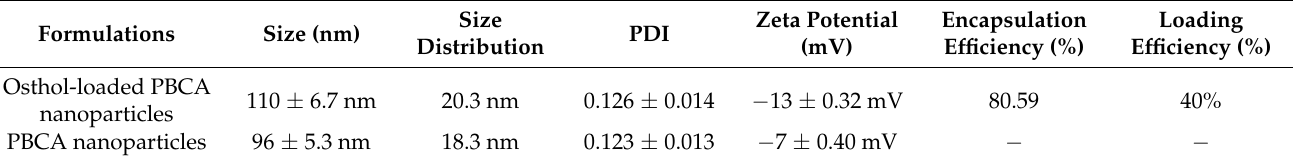
Figure 3. Particle size and morphology of the nanoparticles. ( a ) Osthol-PBCA NPs prepared were 110 nm ± 6.7 nm after screening by an orthogonal design study. ( b ) Morphology of the nanoparticles obtained by TEM ( × 30,000). ( c ) DSC and ( d ) FTIR spectrum of osthol, PBCA, and osthol-PBCA NPs. Table 5. Particle size, zeta potential, and EE of the optimum osthol-PBCA NPs ( n = 3).